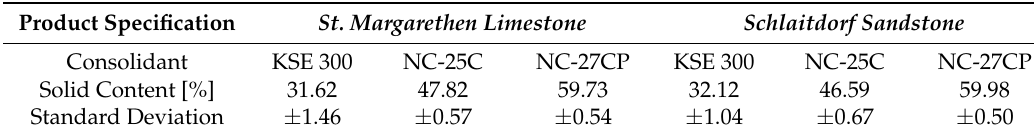
Figure 5. Microscopic views of thin sections made with a polarised-light microscope under UV-light using a fluorescent resin: ( a ) St. Margarethen Limestone in sound condition and ( c ) St. Margarethen Limestone in artificially aged condition displaying micro cracks mostly of an intra-granular nature passing through the microfossils; ( b ) Schlaitdorf Sandstone in sound condition and ( d ) Schlaitdorf Sandstone in artificially aged condition showing micro cracks mostly of an inter-granular nature affecting the grain boundaries. Table 2. Gel deposition rate or solid content of cured consolidants calculated gravimetrically on three specimens per stone and treatment after 4 weeks of curing. As already mentioned in the text, the values reported may not be definite because of the incomplete reaction at this